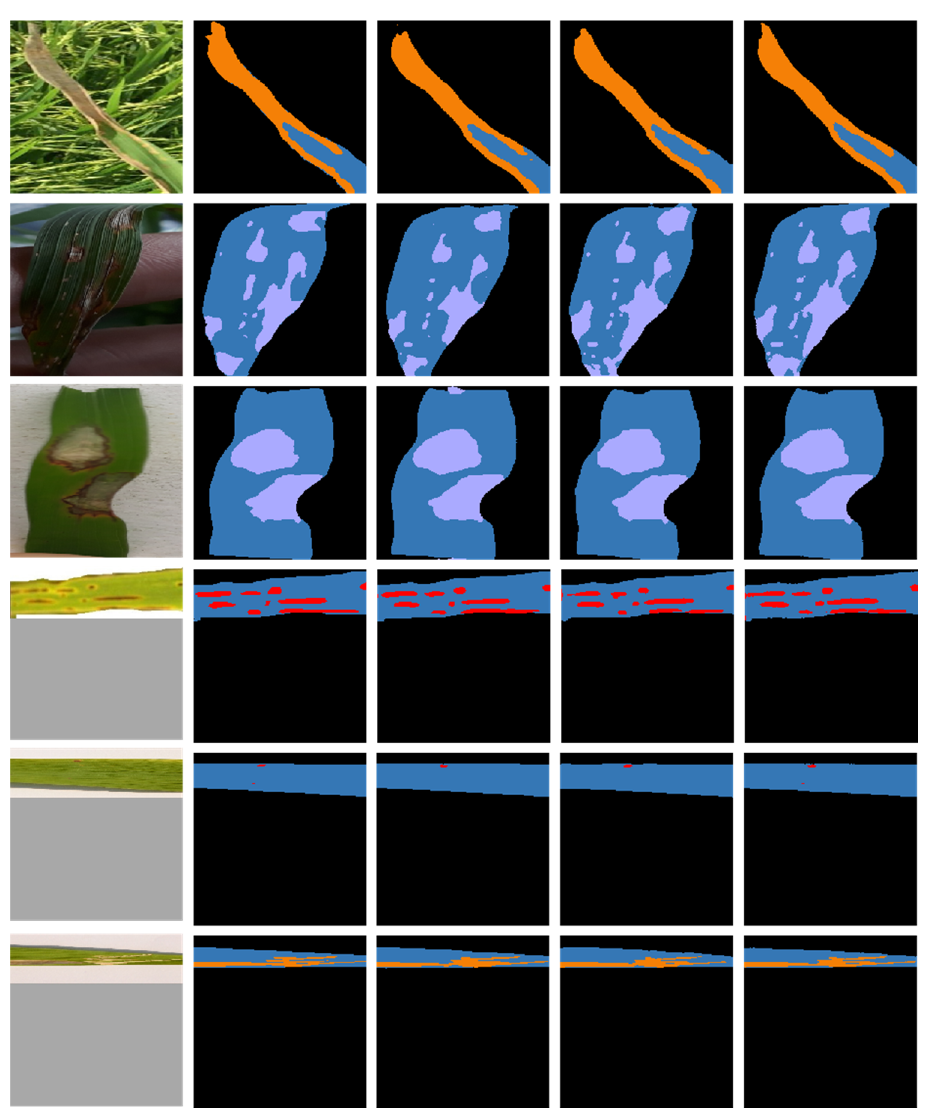
Figure 8. Example inference results for the validation sets on the three models. The first column represents the real images, the second column represents the real labels, the third column shows the inference results for the DeepLabv3+ network model, the fourth column shows the inference results for the Segformer network model, and the fifth column shows the inference results for the RSegformer network